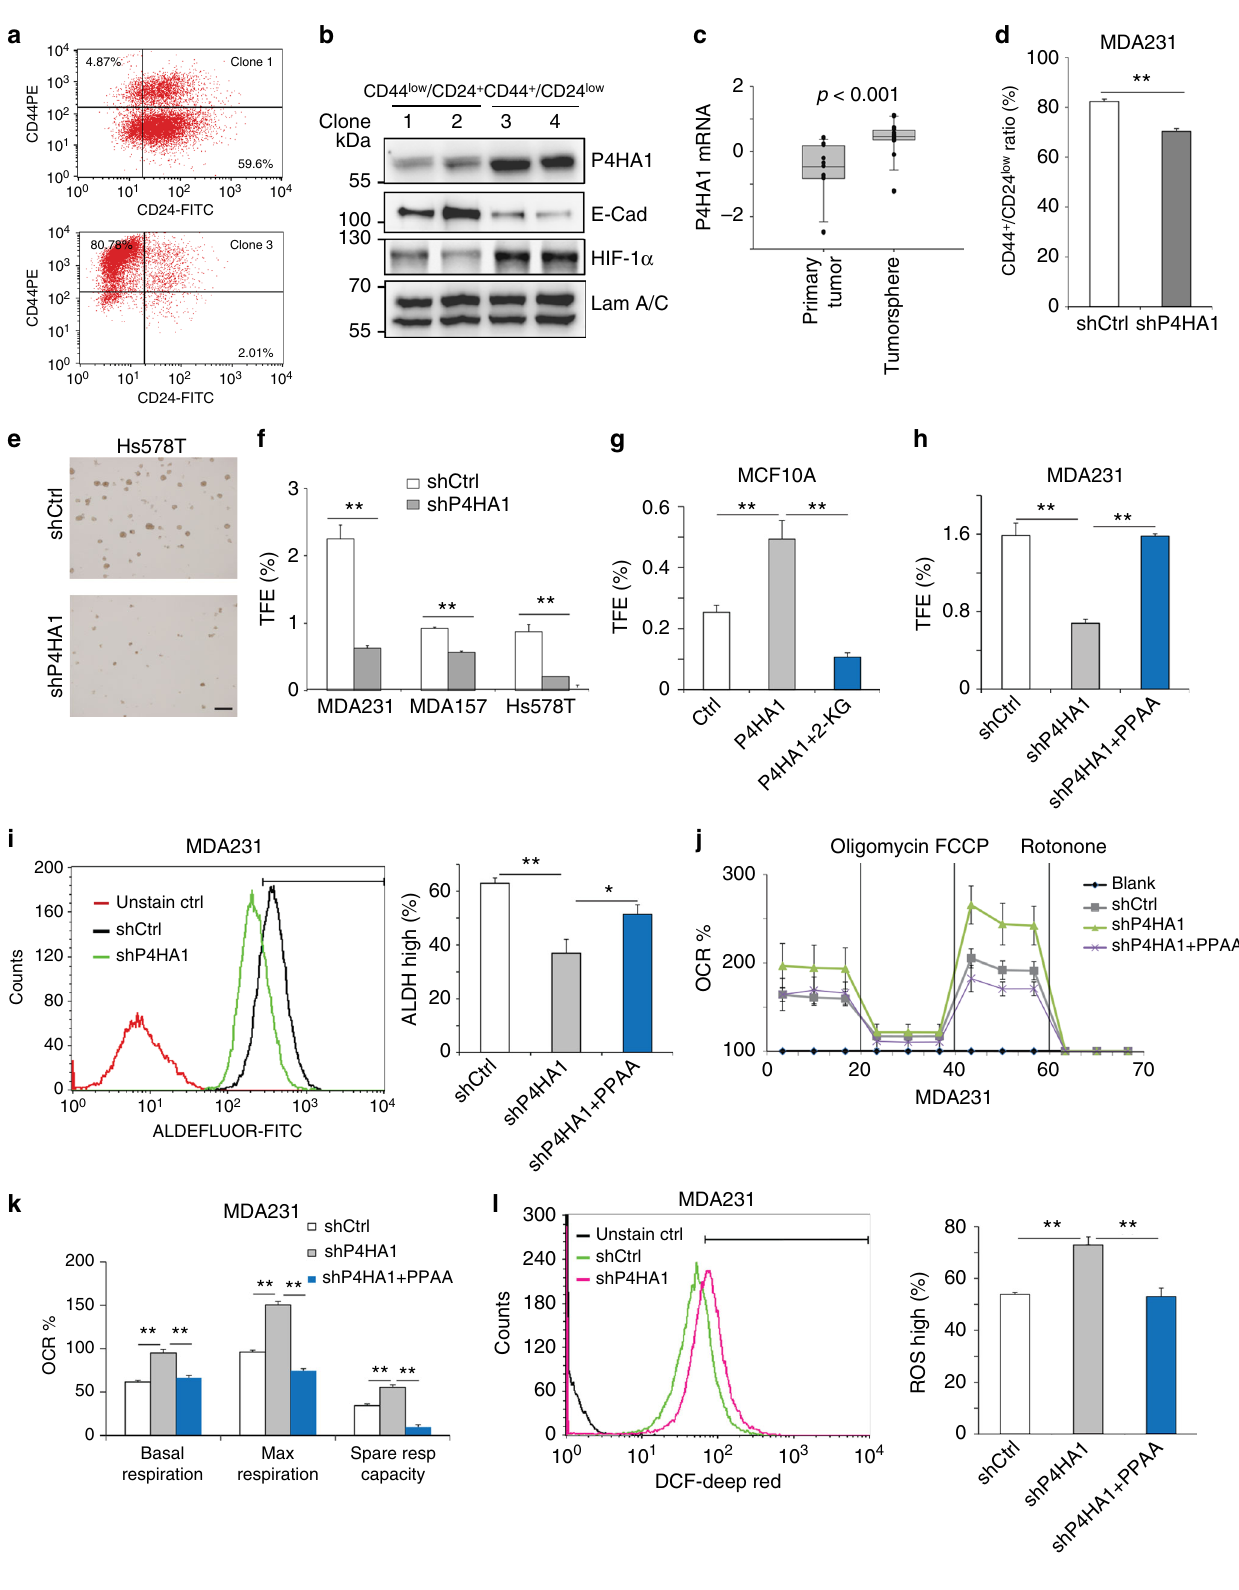
colonization of MDA-MB-231 cells in lung and other organs (Fig. 6a, b) and the level of HIF-1 α protein in metastasis lesions (Supplementary Fig.